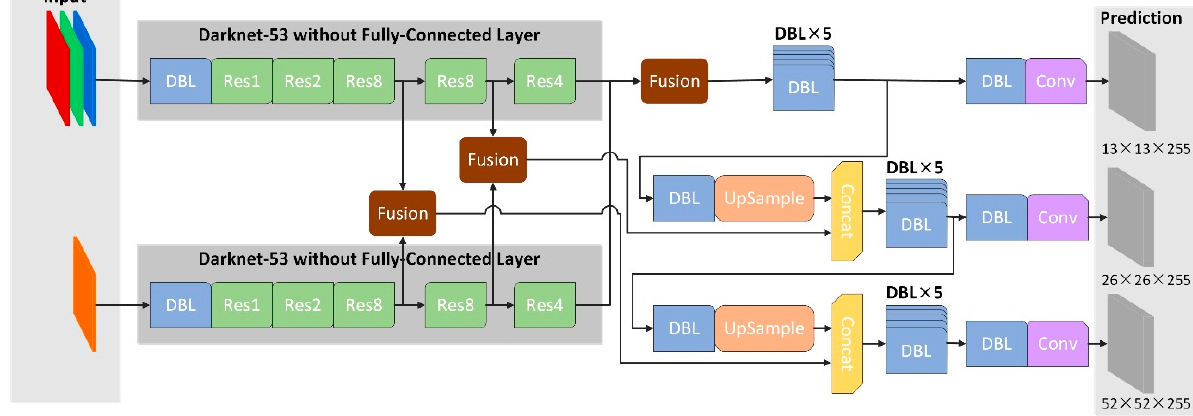
Figure 5. Late fusion architecture based on YOLOv3.